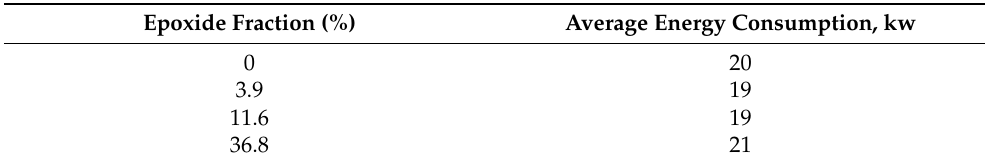
Table 2. Energy consumption of guayule natural rubber/epoxidized guayule natural rubber blend composites at various epoxide